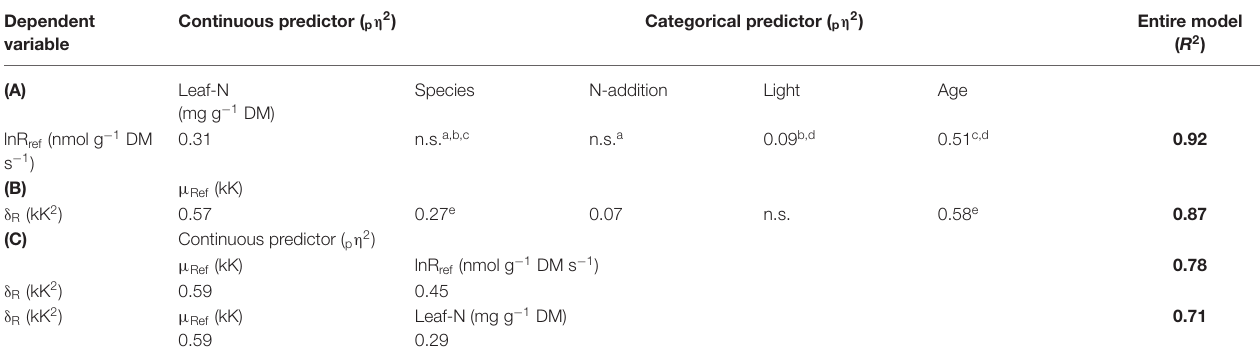
TABLE 4 | Results of analysis of co-variance (ANCOVA).